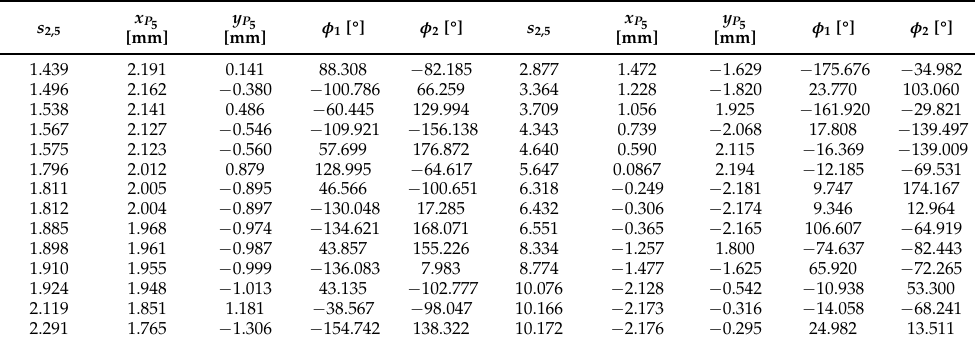
Table 5. All 28 possible solutions of the DKP for the 4-RR architecture in Table